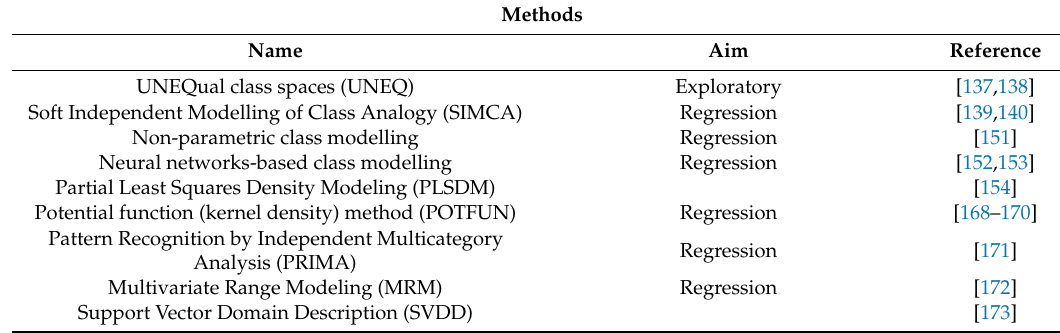
Table 2. Main class modelling methods and application examples in the field of spectroscopy-based food analysis. PGI and PDO stand for Protected Geographical Indication and Protected Designation of Origin,